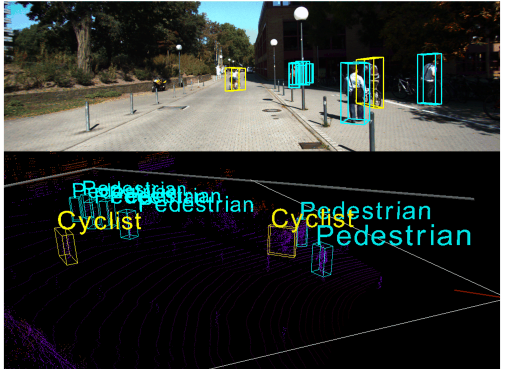
Figure 11. Qualitative results for cyclist and pedestrian categories on the KITTI